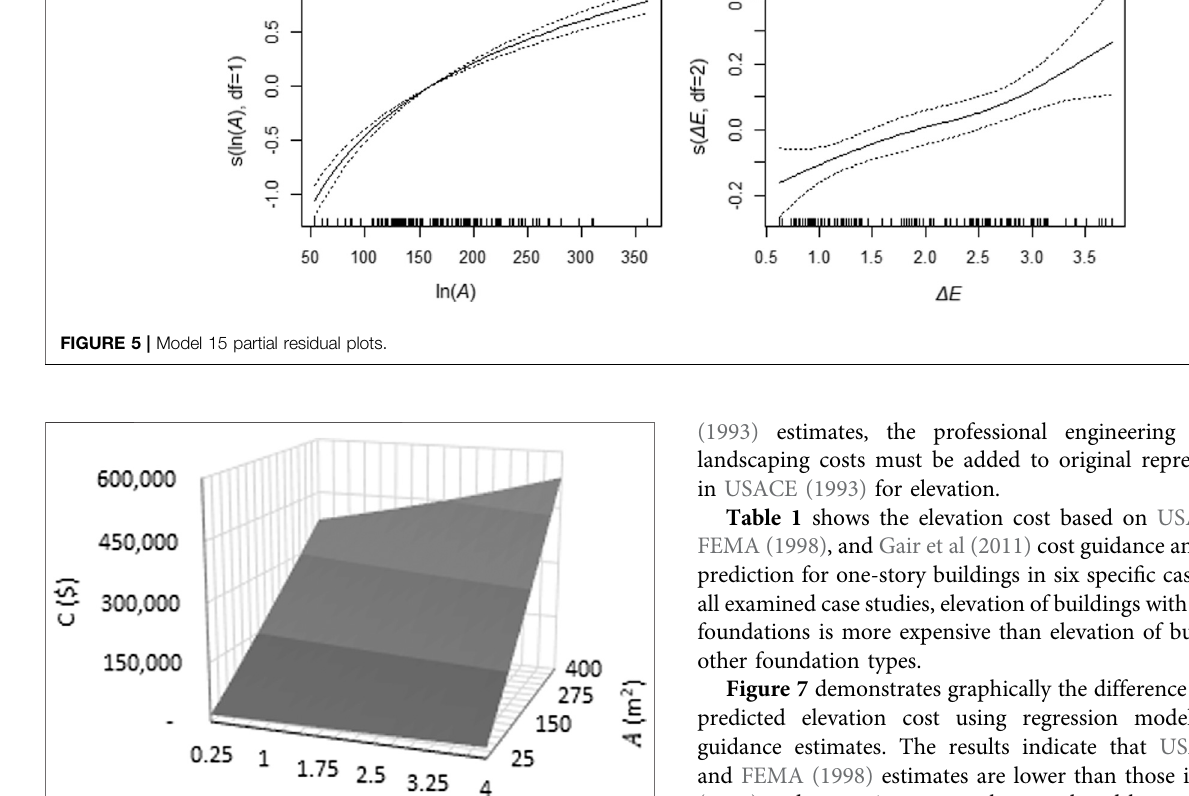
Frontiers in Built Environment |